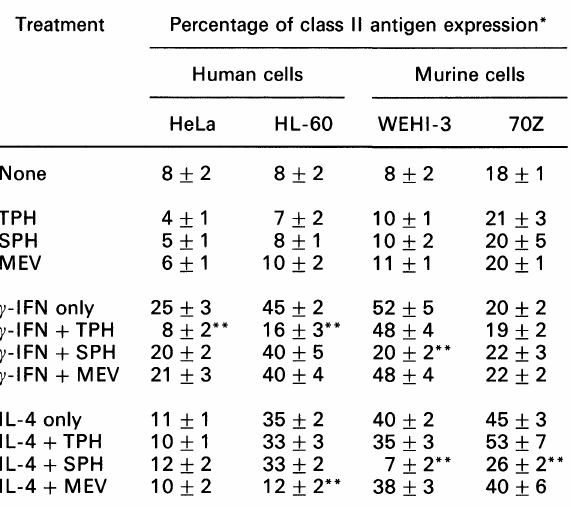
Table 1. Pathways followed during the induction of class II antigens in human and mouse cells after treatment with recombinant /-I FN and